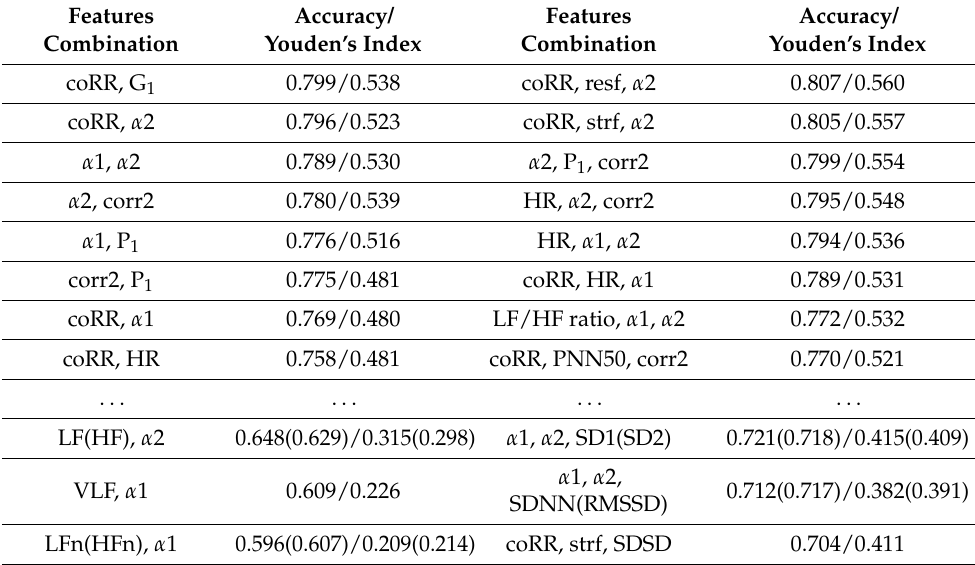
Table 7. Method of excluding “useless features” for REM stage